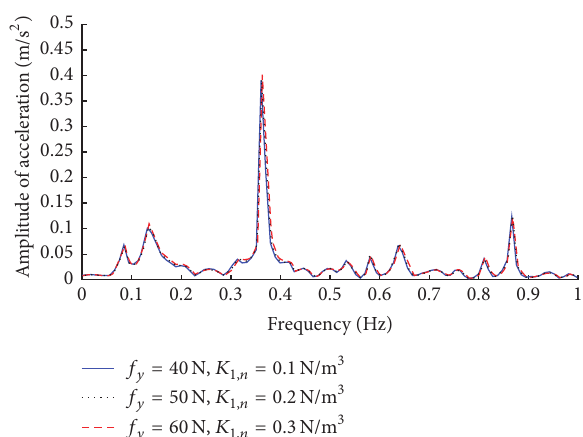
Figure 13: The comparison of frequency response curves for different parameters when the force amplitude 𝐹 exc = 100 N.